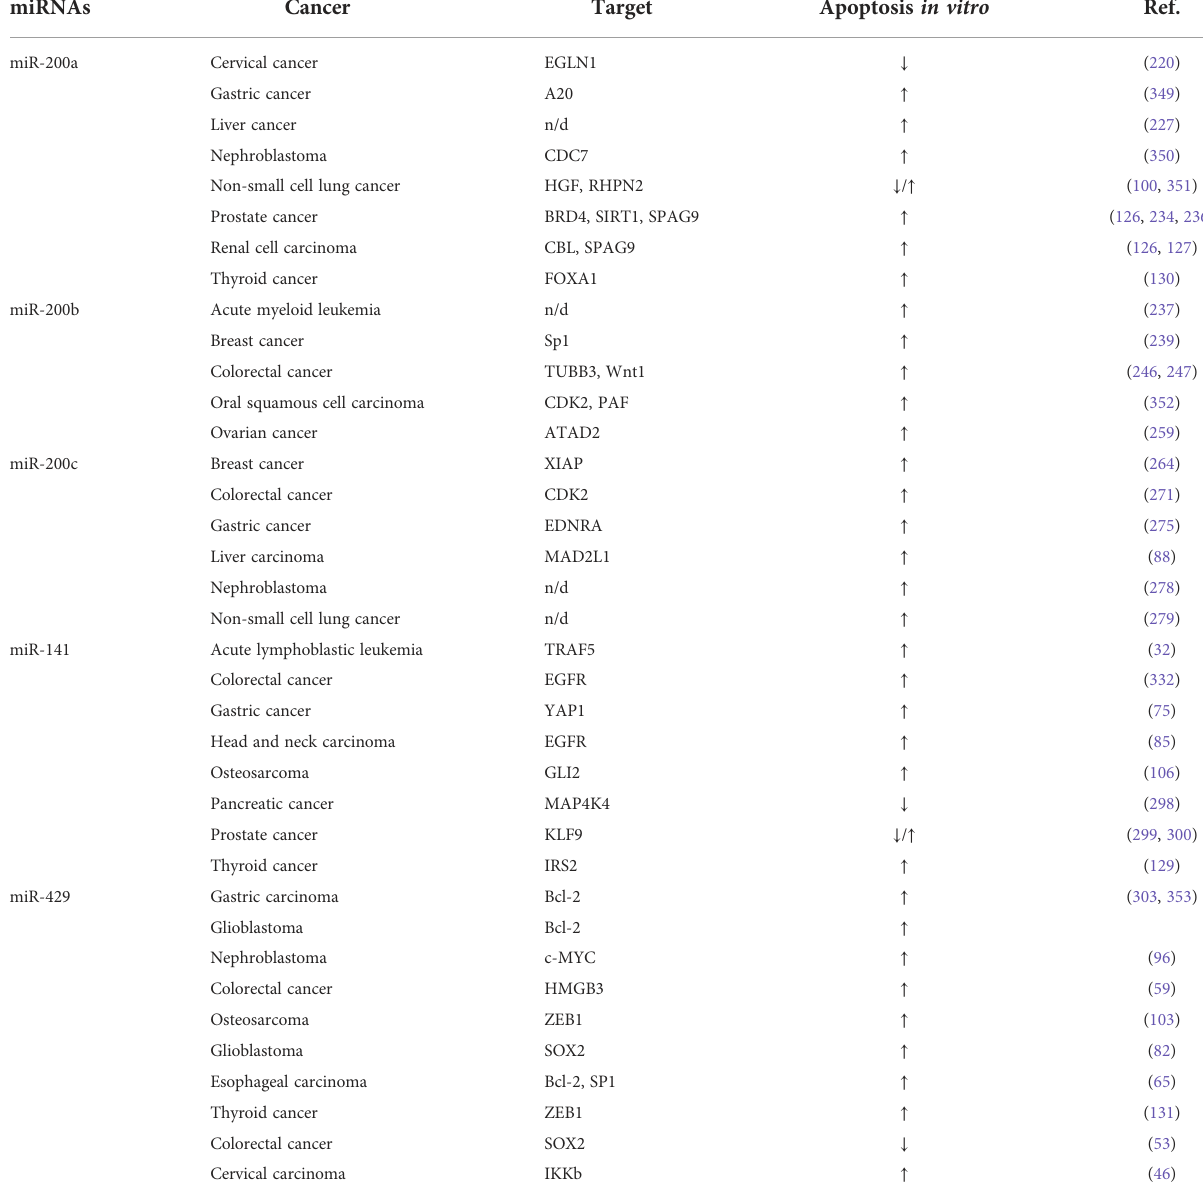
TABLE 5 Members of the miR-200 family regulating apoptosis. miRNAs Cancer Target Apoptosis in vitro